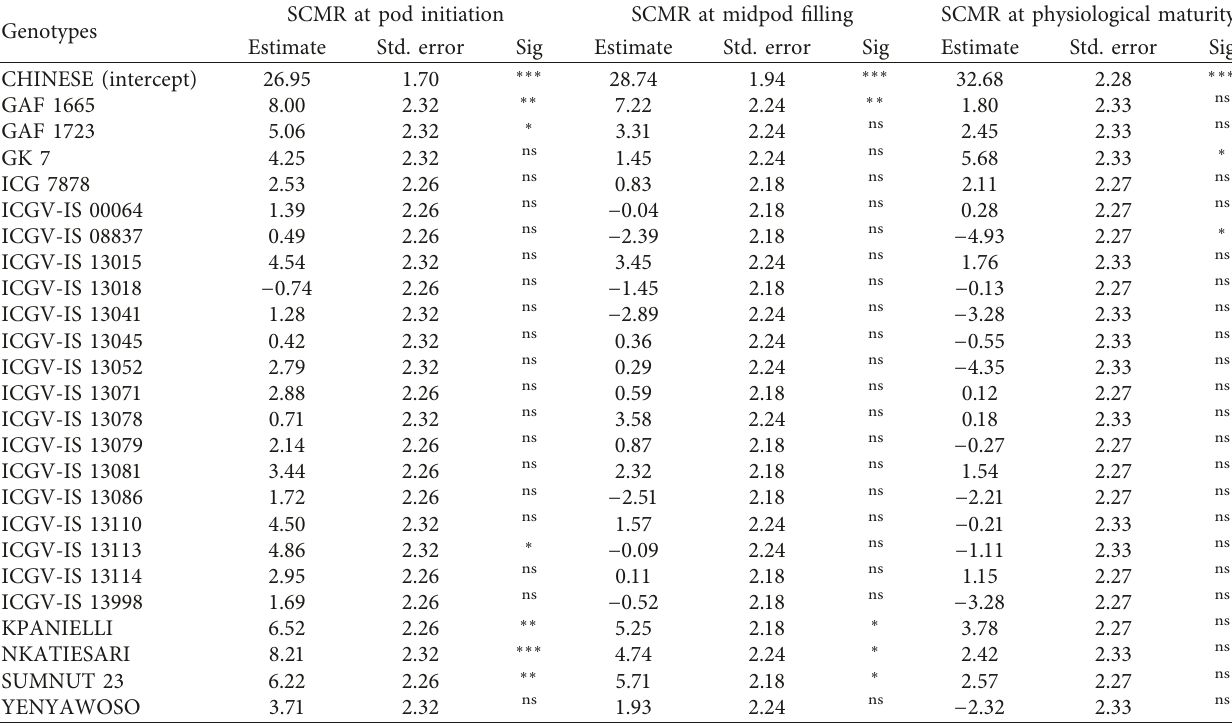
Table 4: Leaf chlorophyll content (SCMR) of 25 groundnut genotypes evaluated under disease-free conditions.